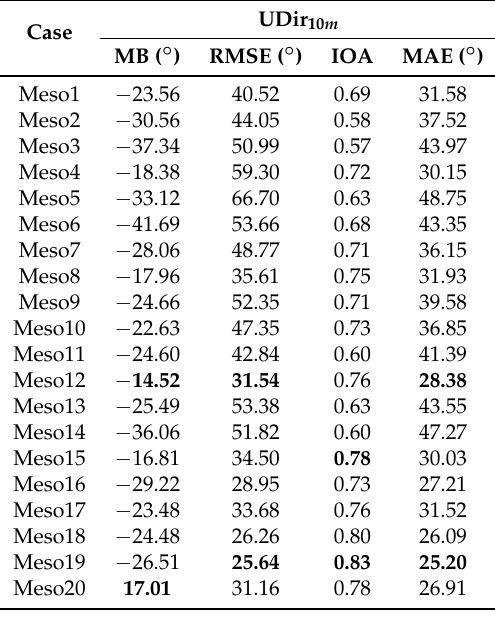
Table A3. Statistical measures for 10-m wind direction in mesoscale simulations performed. Bold values represent the best